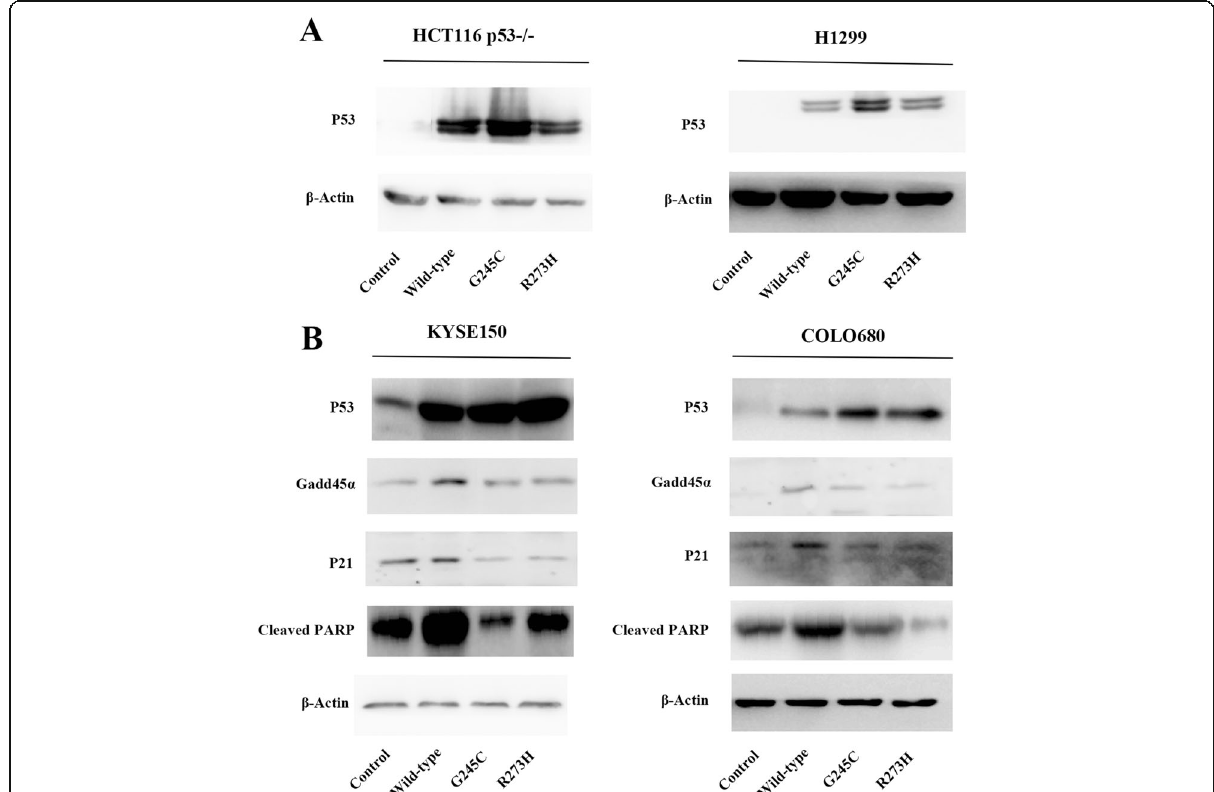
Fig. 5 TP53 and its downstream proteins ’ expression levels. a The expression levels of P53 in p53-defective cell lines H1299 and HCT116 p53 − / − after UV 30 J for 12 h treatment. b Mutant TP53 R273H and R273C reduced the protein levels of P21, GADD45 α and cleaved PARP after UV 30 J for 12 h treatment in KYSE150 and COLO680. Western blot of TP53 downstream proteins P21, GADD45 α and cleaved PARP expression levels in KYSE150 (right) COLO680 (left) cell lines after UV 30 J treatment for 12